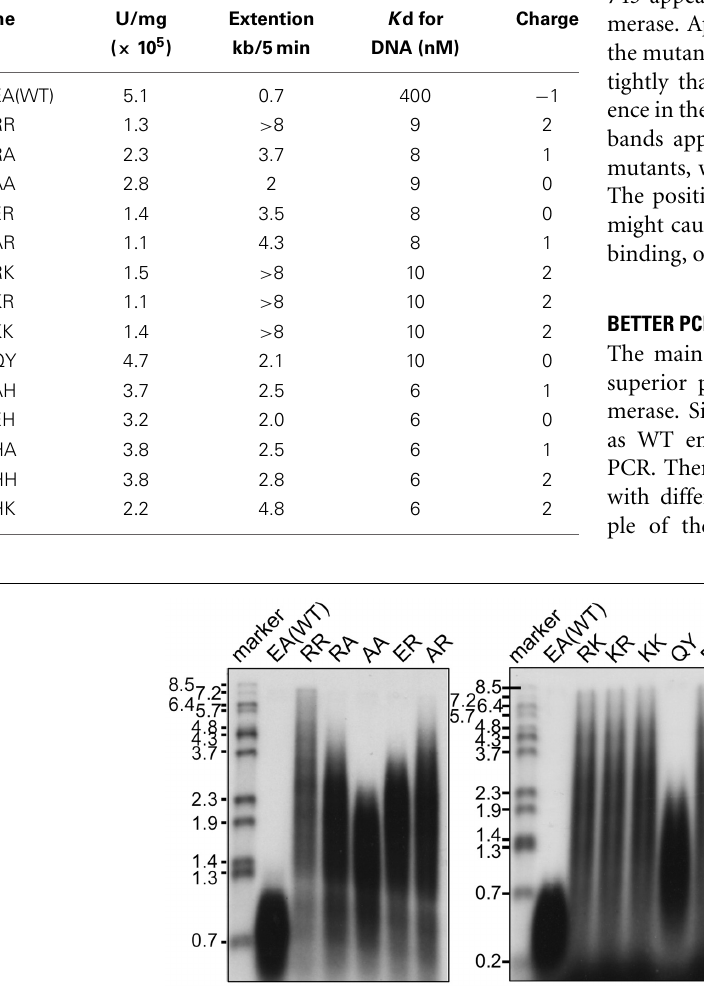
mixtures were incubated at 74 ◦ C for 5min, and the products were analyzed by 1% alkaline agarose gel electrophoresis, followed by autoradiography. The sizes indicated on the left are from BstPI-digested λ phage DNA labeled with 32 P at each 5 (cid:2) end. The names of the proteins were indicated on the